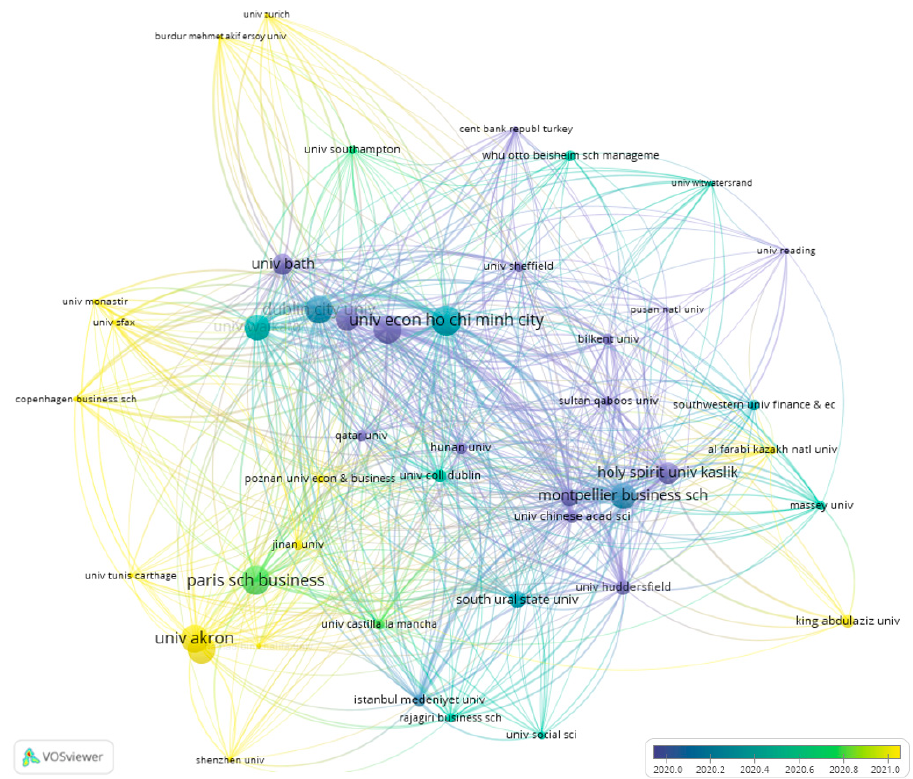
Figure 3. Normalized citations of institutions by year.